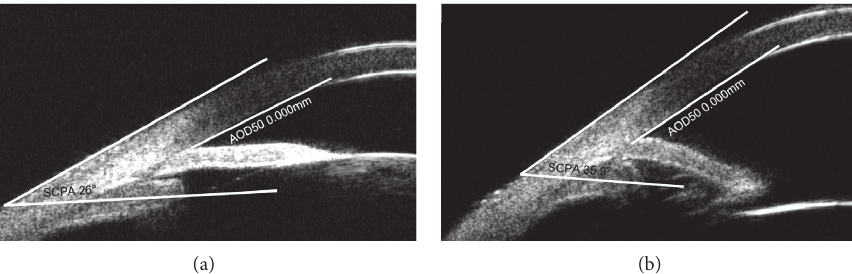
Figure 3: Example of the UBM of the same patient shown in Figure 2 before and after treatment. (a) Preoperative analysis of the nasal angle showed that the SCPA and AOD50 were 26 ° and 0mm, respectively. (b) Postoperative analysis of the same angle demonstrated that the SCPA and AOD50 were 35.9 ° and 0mm,